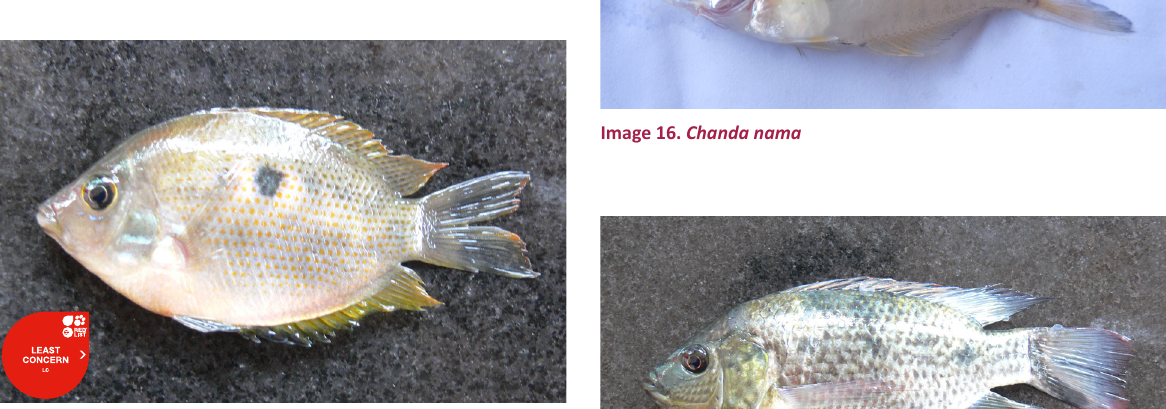
Image 15. Mastacembelus armatus